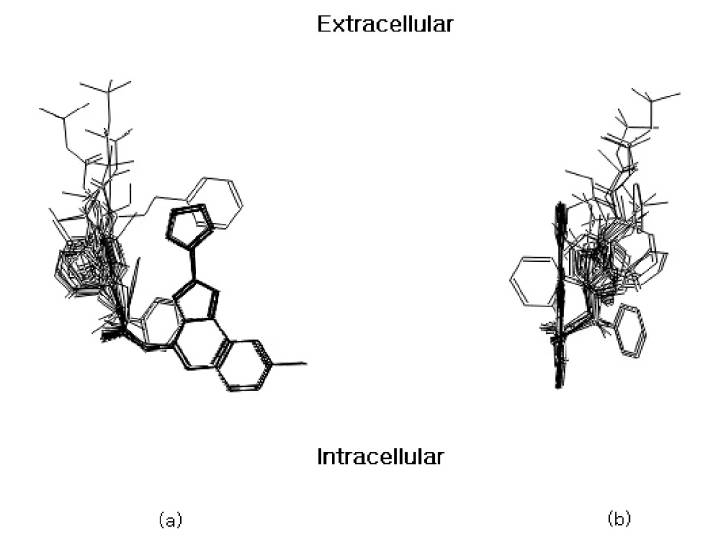
Figure 1. Front (a) and side (b) view of the aligned molecules on the membrane plane. The furan ring has been reported to point in an extracellular direction